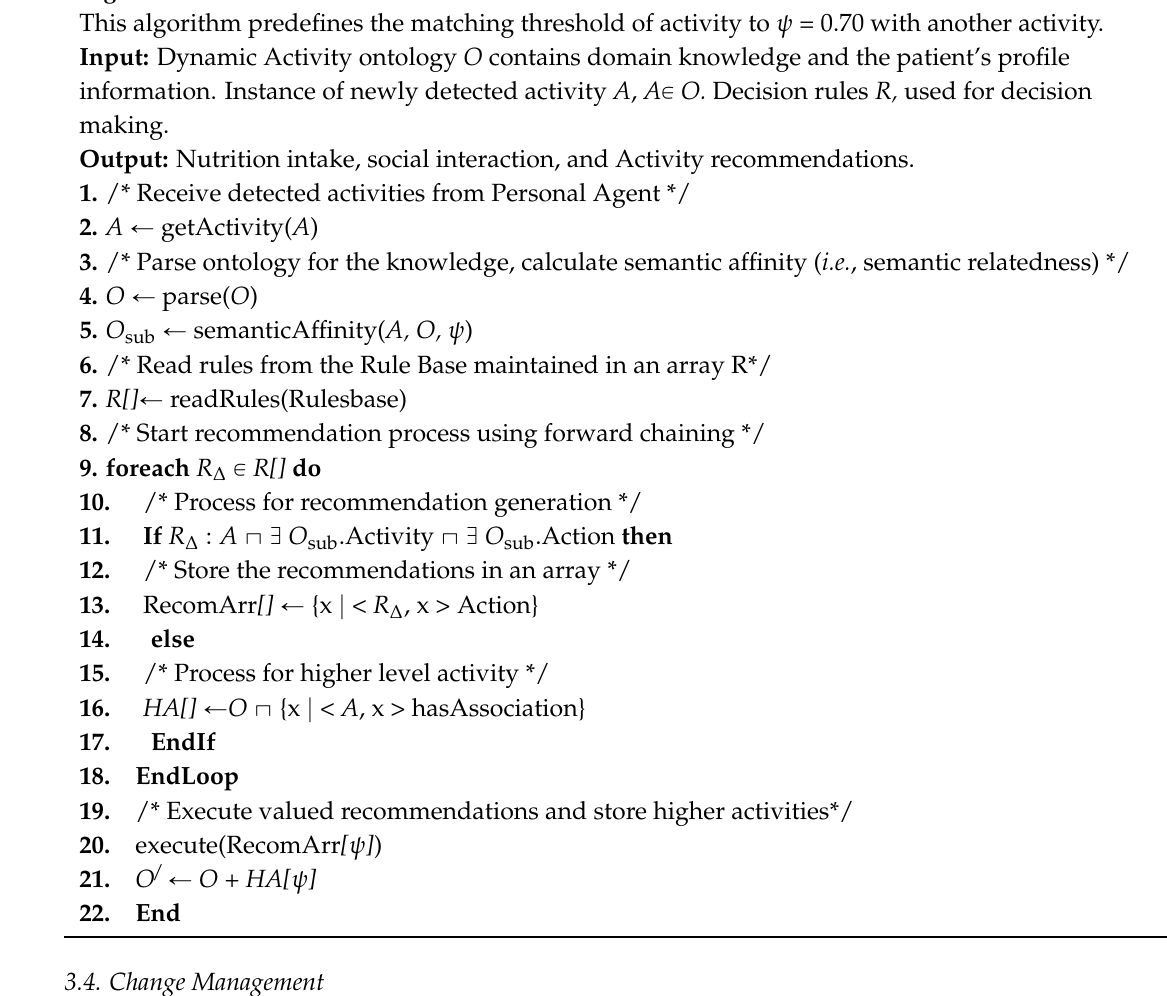
Algorithm 1. Algorithm for activity information collection, manipulation, situation analysis, and recommendation